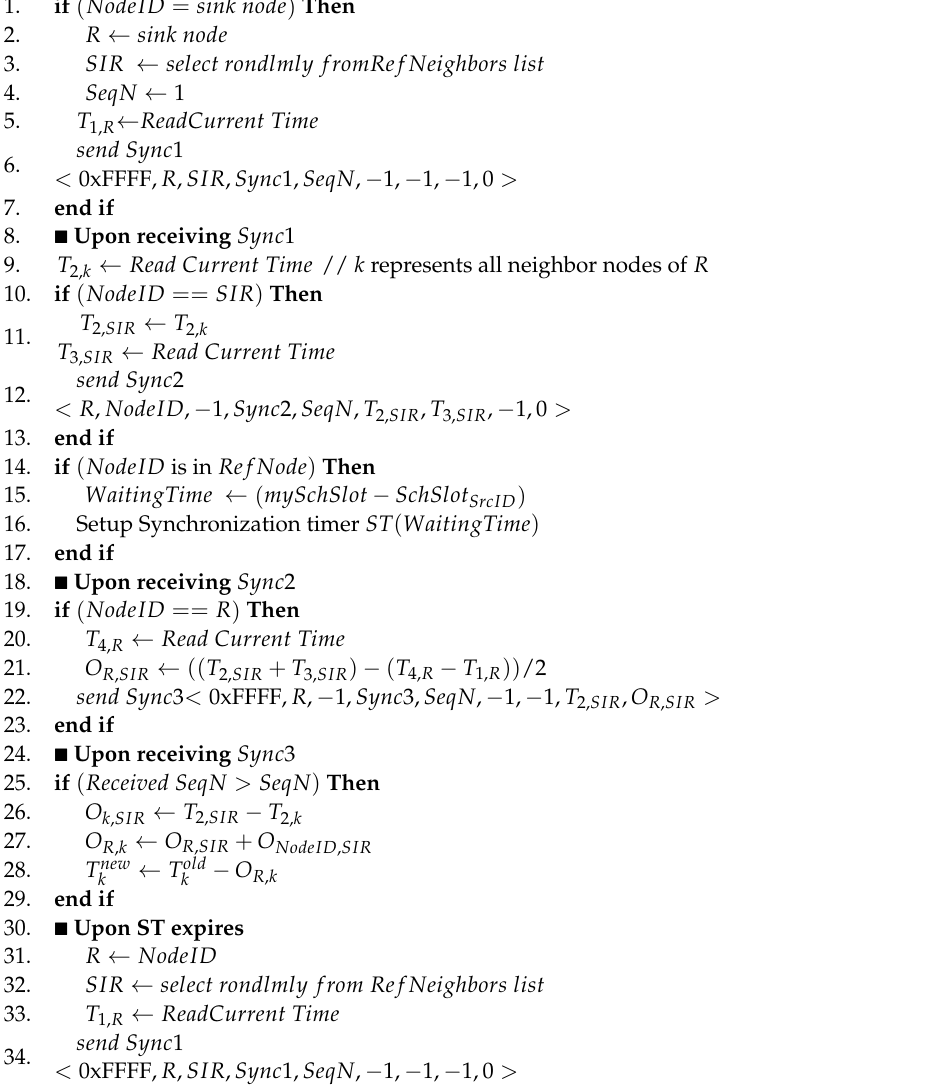
Algorithm 3 : LPSRS pseudo-code for the synchronization